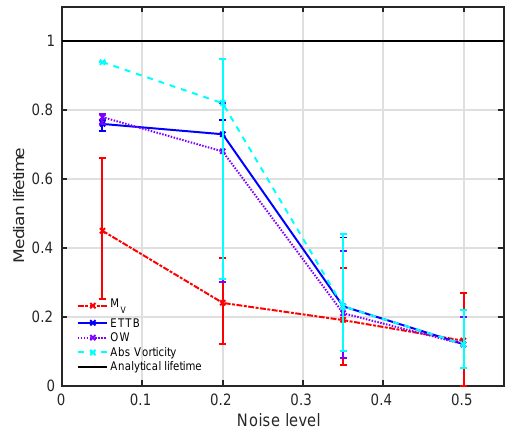
Figure 9. Measured median lifetime obtained by different methods (Okubo–Weiss (OW, violet), the modulus of vorticity (absVorticity, cyan), M V (red) and the eddy tracking tool box (ETTB, blue) by Nencioli et al. (2010)) depending on the noise level. The compu- tations have been performed in a velocity field mimicking a vortex street with type 3 noise (1000 noise realizations). The error bars in- dicate the whiskers of the distribution in the box plot (not shown here) corresponding to approximately ± 2.7 σ